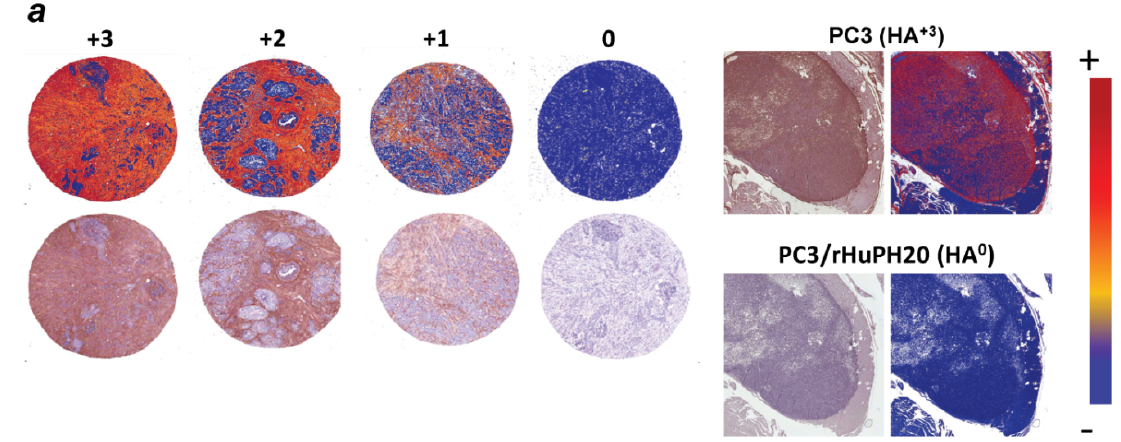
Figure 1. HA accumulation occurs in 87% of pancreatic cancer, and 25 − 30% of solid tumors overall. ( a ) HA was detected in samples by immunohistochemistry using biotinylated HA binding protein as described in Jacobetz et al. [11]. A score of HA +3 corresponds to >25% strong positive stain area as compared to the total stain per field. PC3 prostate cancer xenografts were used as a positive control to determine the threshold for positive pixel quantity. Specificity of the staining was confirmed by pretreating a section of same sample with PH20 hyaluronidase in parallel with the test section; ( b ) The percentage of HA +3 tumors in different tumor types